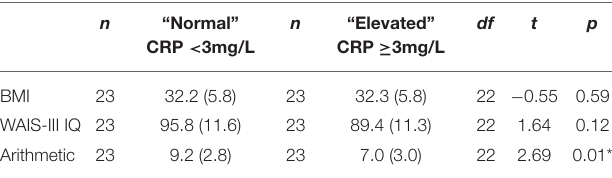
TABLE 10 | Comparison of current IQ and working memory measures between normal and elevated CRP schizophrenia groups matched on BMI.